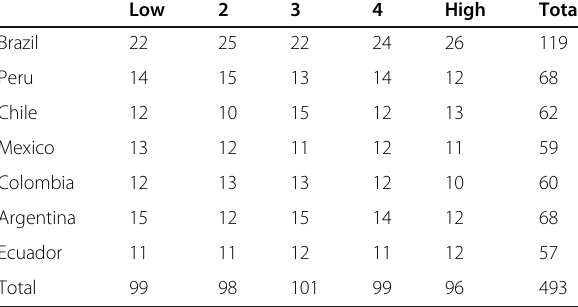
Table 2 Sample distribution (HCE sort)